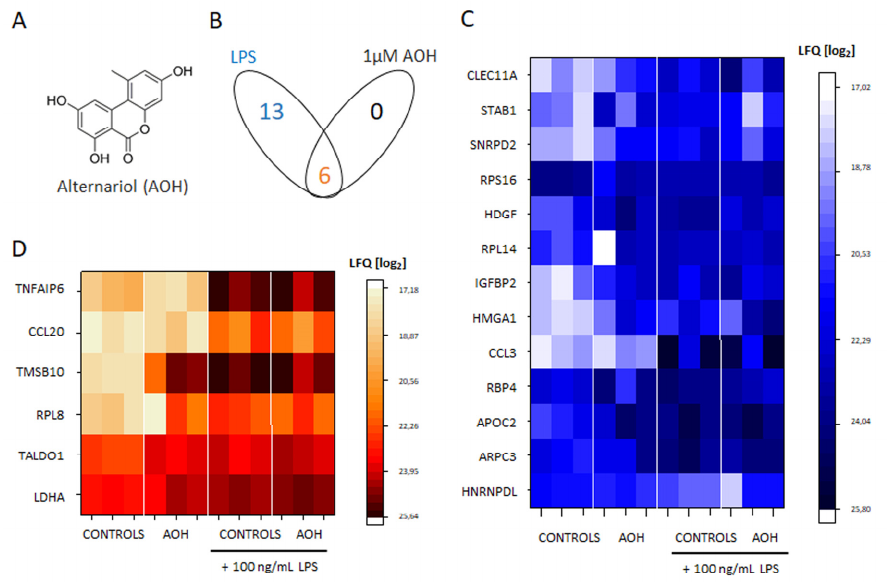
Figure 1. ( A ) Structure of alternariol AOH. ( B ) Significantly regulated proteins in the secretome of THP-1 macrophages, after 5 h incubation with 100 ng / mL LPS, 1 µ M AOH or combination of the two. ( C ) Thirteen proteins regulated exclusively by incubation with 100 ng / mL LPS. ( D ) Six proteins regulated by co-incubation with 100 ng / mL LPS and 1 µ M AOH. The heat map depicts the three biological replicates performed for each treatment